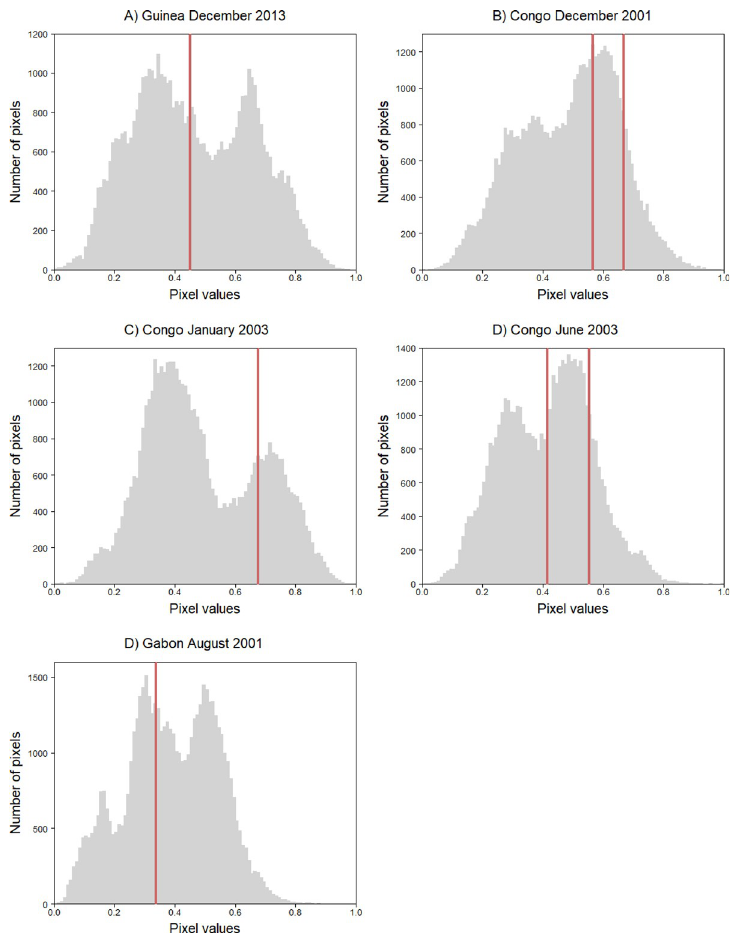
Fig 6. Pixel values distribution in suitability maps for EBOV spillover in Guinea, Congo and Gabon. Red lines show pixel values of sites where EBOV spillover were